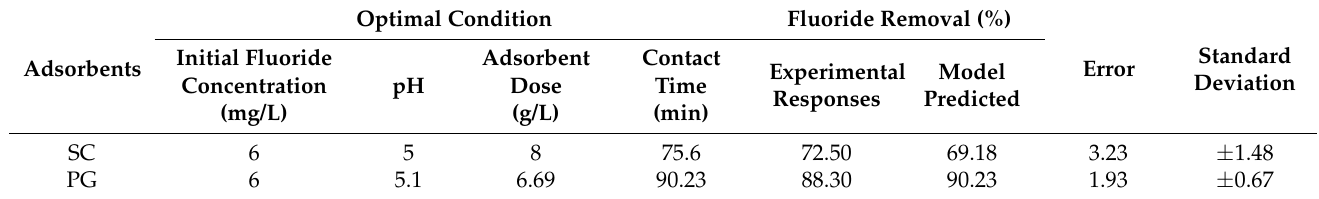
Standard DeviationInitial Fluoride Error